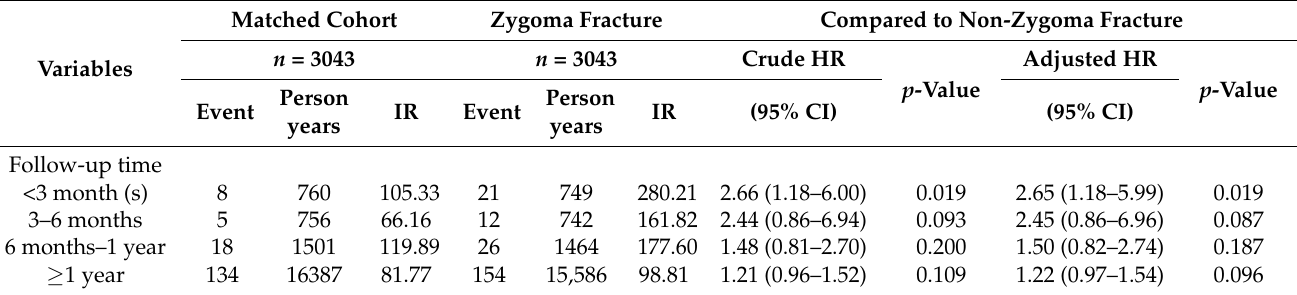
Table 4. Incidence rates, hazard ratio and confidence intervals of post-traumatic headache in different follow-up stratification.